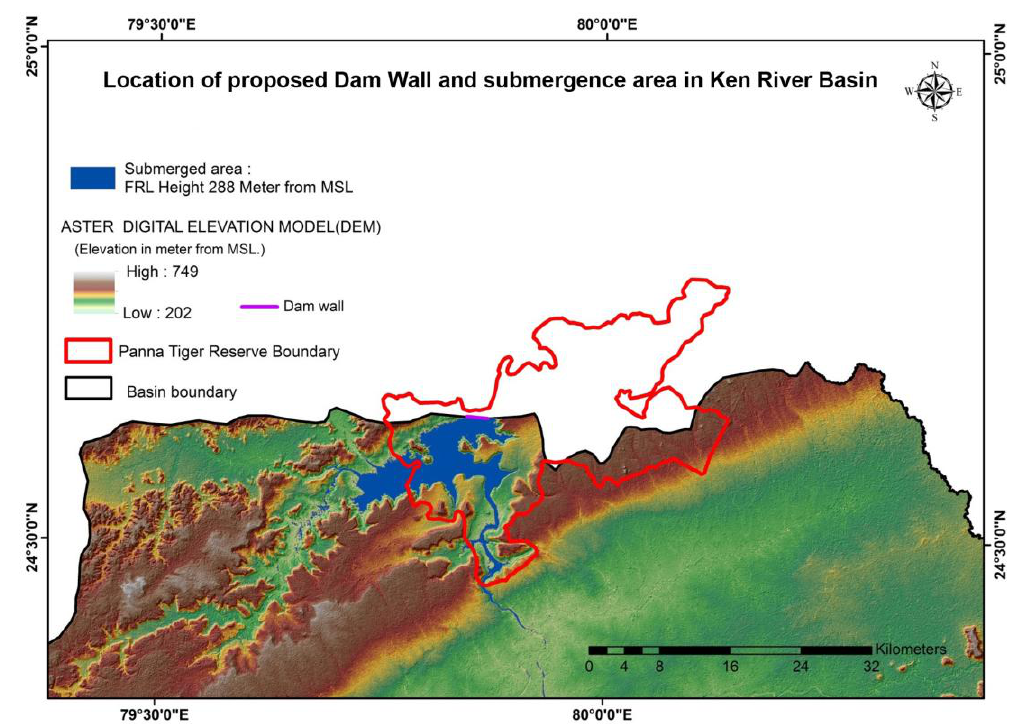
Fig. 2. Proposed Dam Wall and submergence area in Ken River Basin